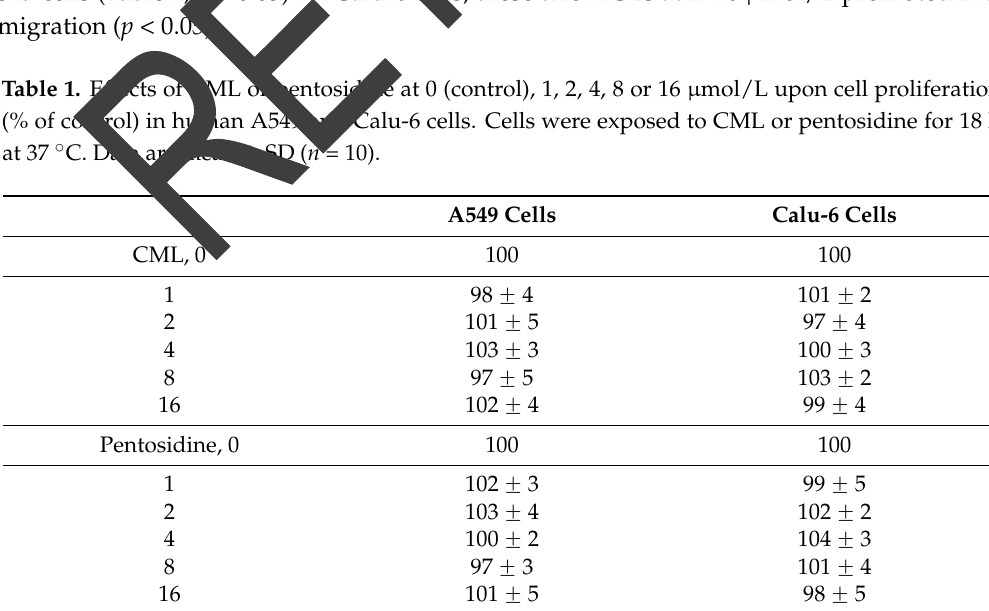
Table 1. Effects of CML or pentosidine at 0 (control), 1, 2, 4, 8 or 16 µ mol/L upon cell proliferation (% of control) in human A549 and Calu-6 cells. Cells were exposed to CML or pentosidine for 18 h at 37 ˝ C. Data are mean ˘ SD ( n =